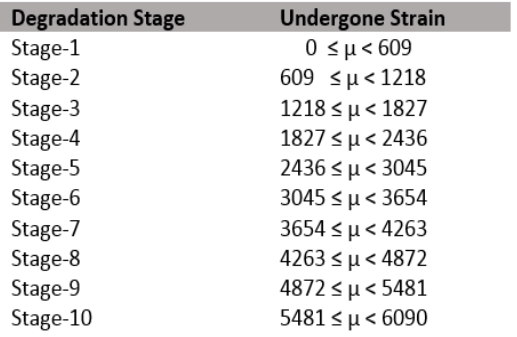
Figure 11. Description of the 10 stages of a tube’s degradation.